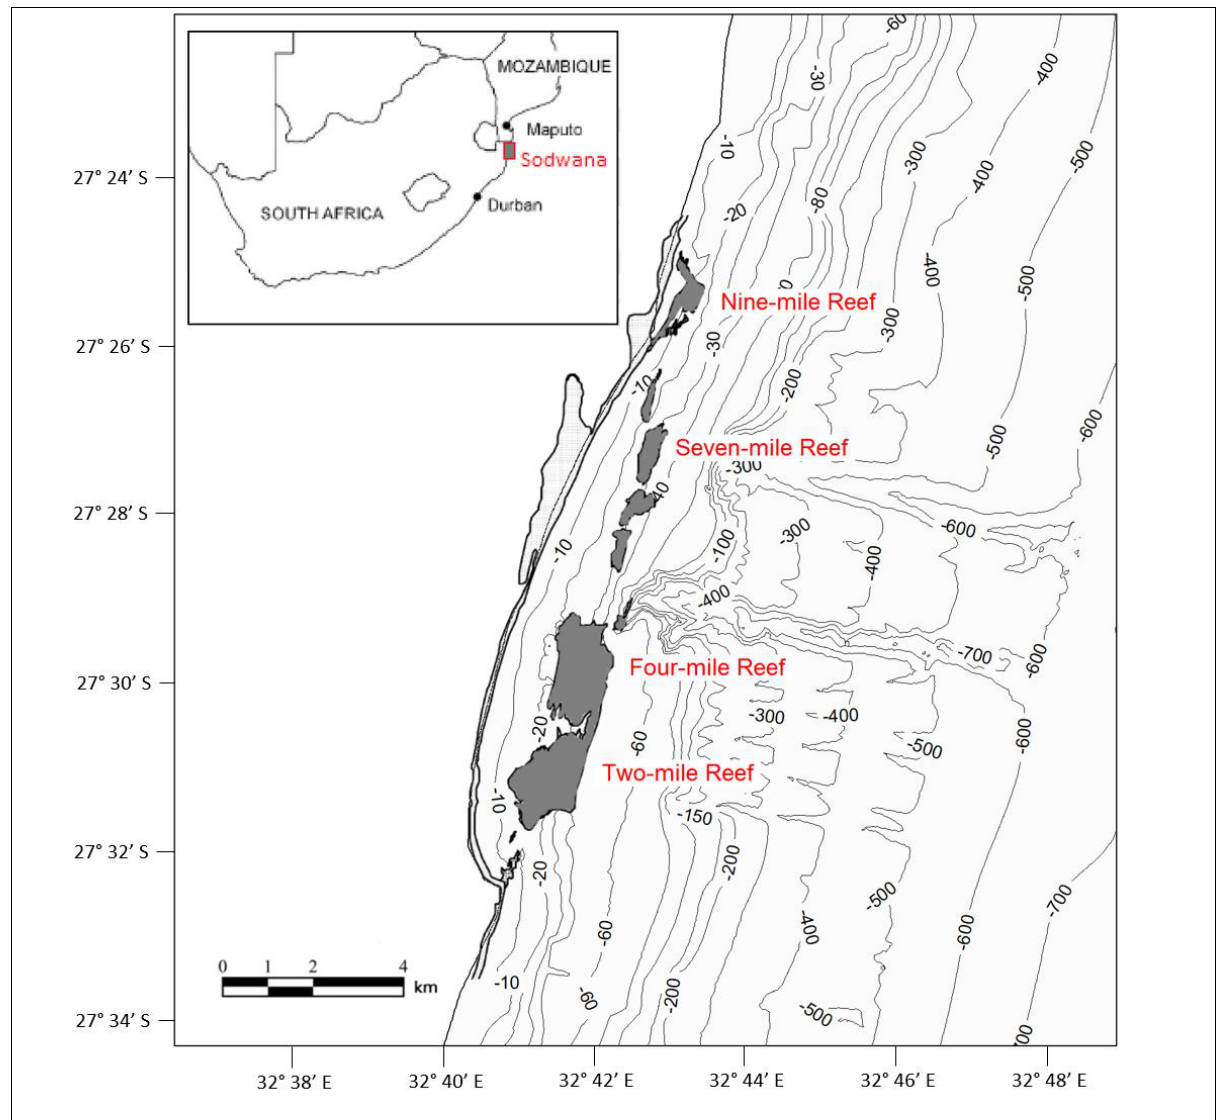
Figure 1: Sodwana Bay location and